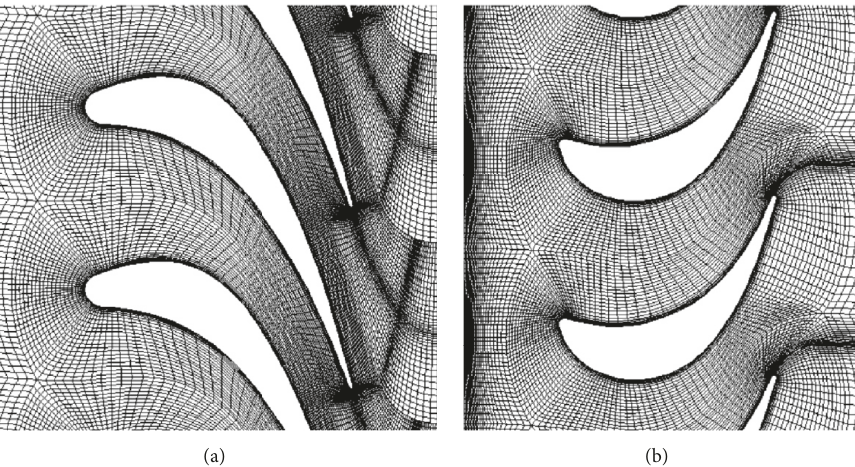
Figure 4: Configuration of the calculating mesh in the middle section of the radial blades (mesh shown in (b) (rotor) and mesh shown in (a) (stator)).